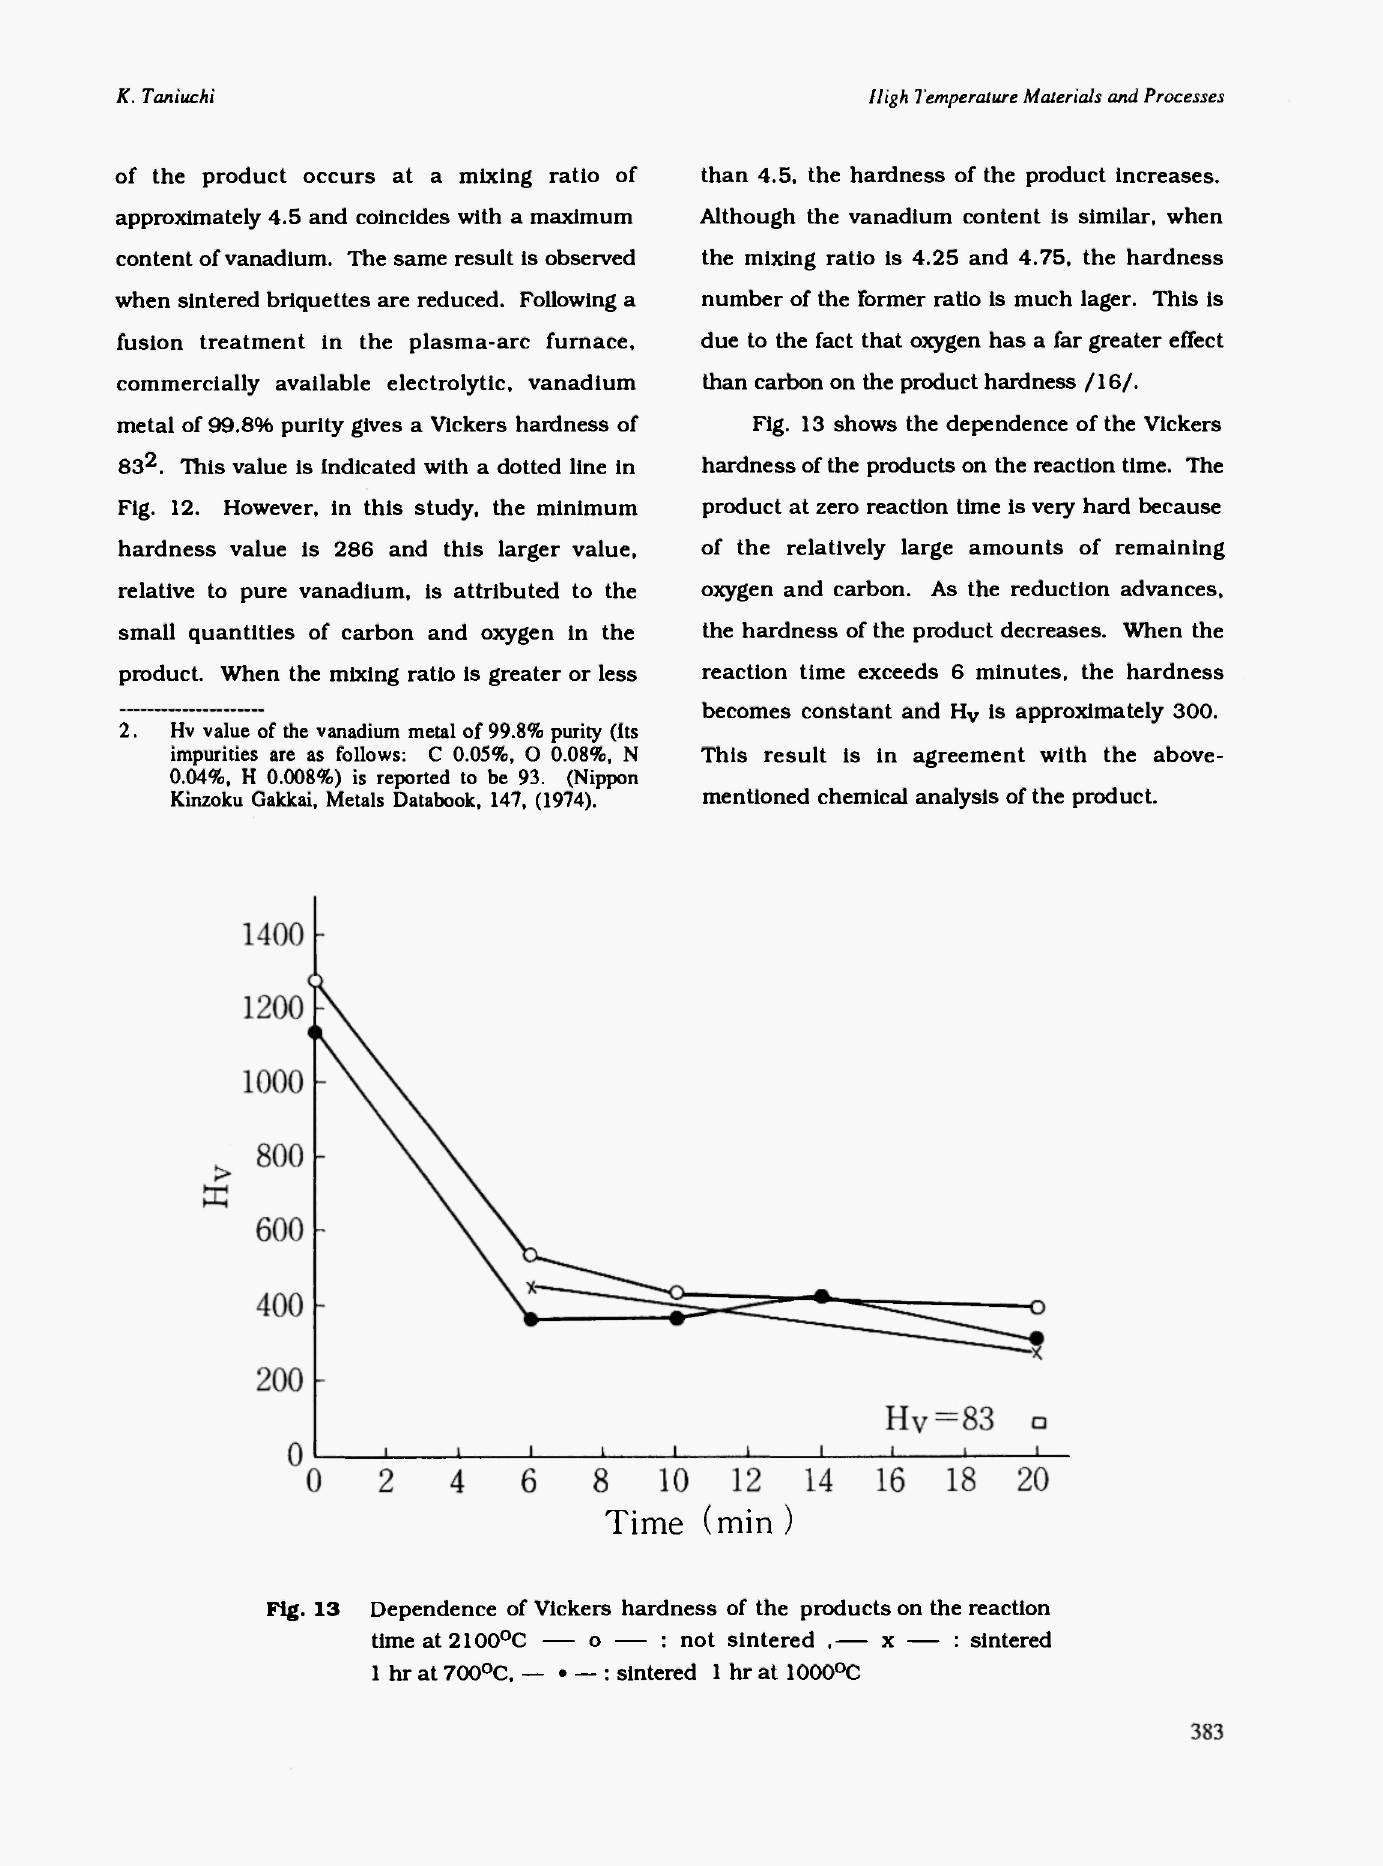
Fig. 13 Dependence of Vickers hardness of the products on the reaction time at 2100°C ο — : not sintered , χ : sintered 1 hr at 700°C, — · — : sintered 1 hr at